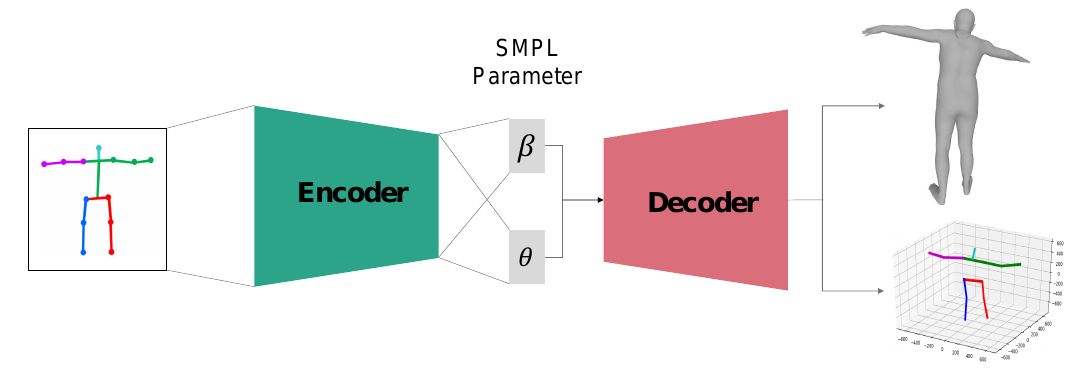
Figure 2. Overview of the